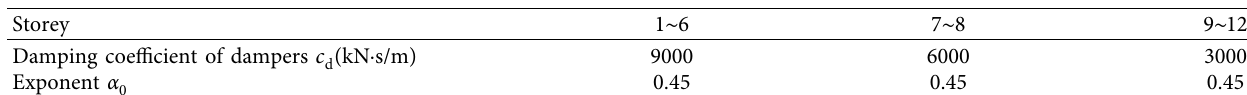
Figure 12: Maximum seismic response of the steel frame: (a) maximum interstorey drifts and (b) maximum absolute Table 3: Parameters of viscous dampers.